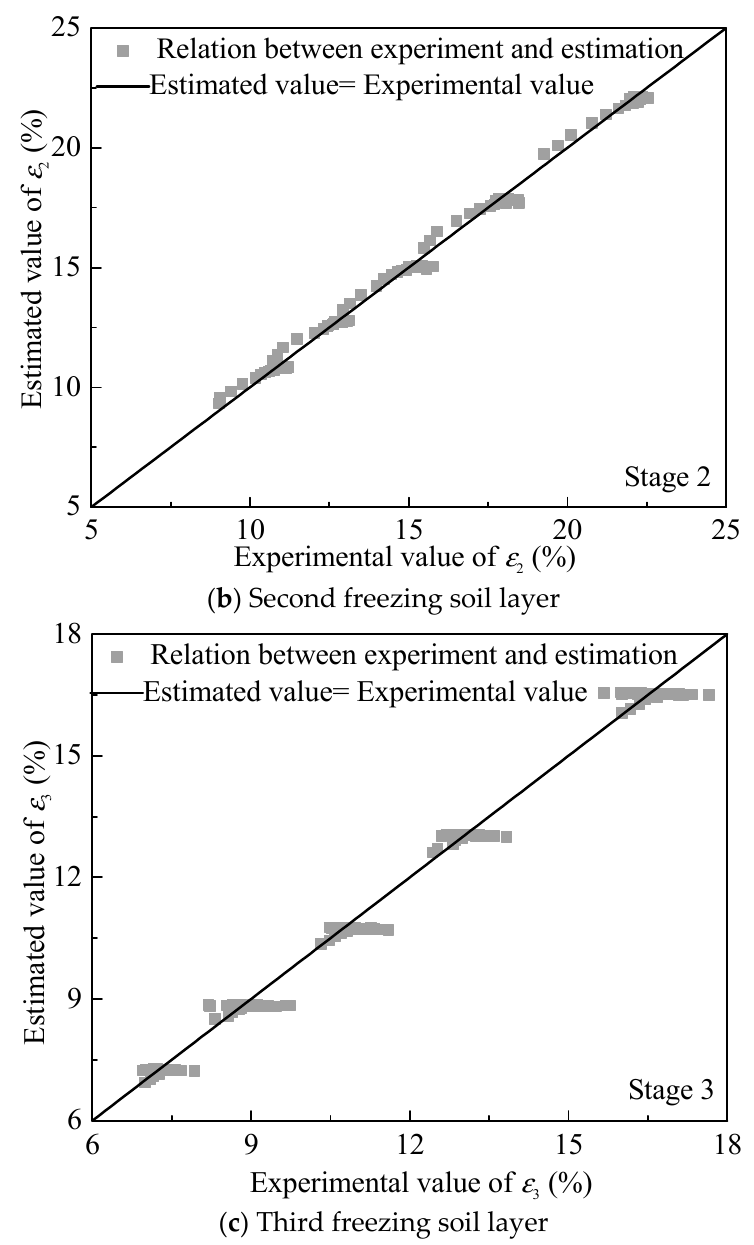
Figure 14. Comparison of frost heave strain between experimental results and the results estimated by equations at ( a ) the first freezing soil layer, ( b ) second freezing soil layer, and ( c ) third freezing soil layer.